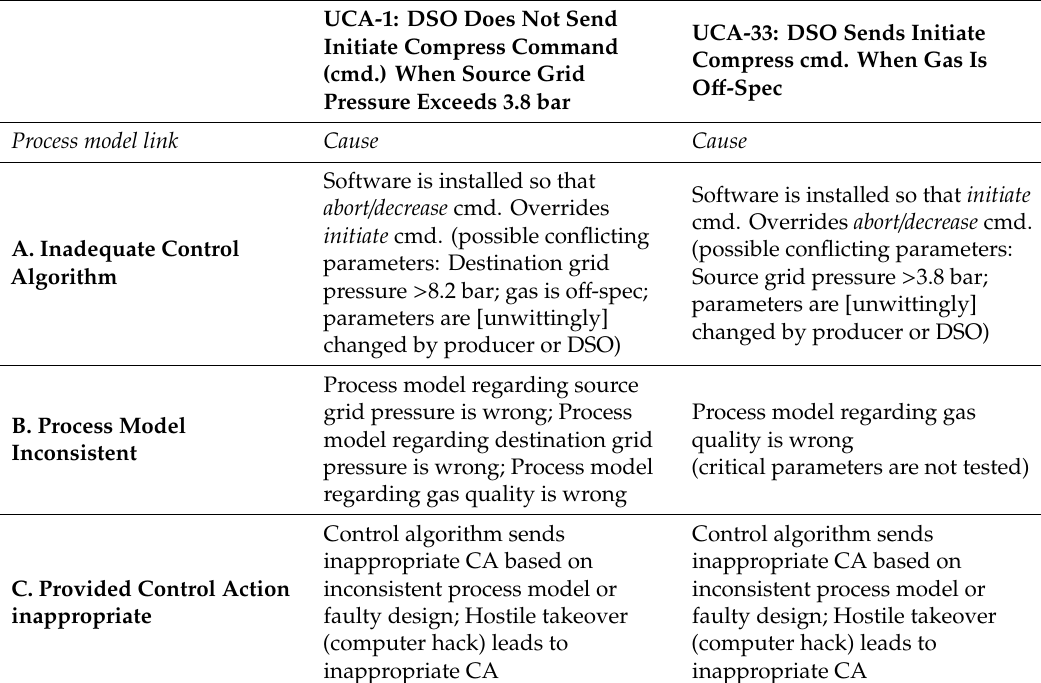
Table 6. Detailed analysis of 2 unsafe control actions (from a total of